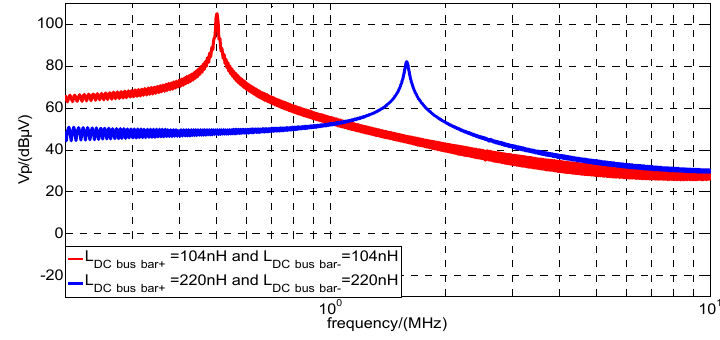
Figure 13. Positive conducted emission(CE) voltage after L DC bus bar+ and L DC bus bar − were increased.